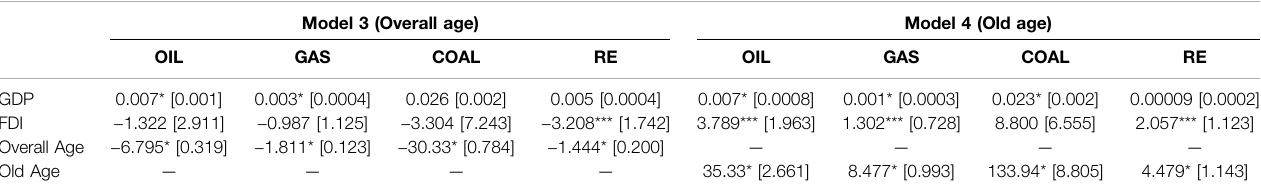
TABLE 6 | Hainmueller and Hazlett (2014) kernel-based regularized least squares.